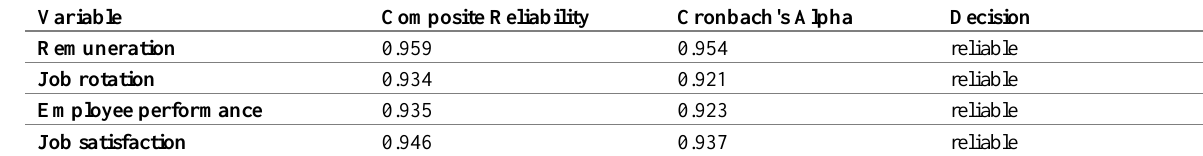
Table 5: Results of Composite Reliability and Cronbach